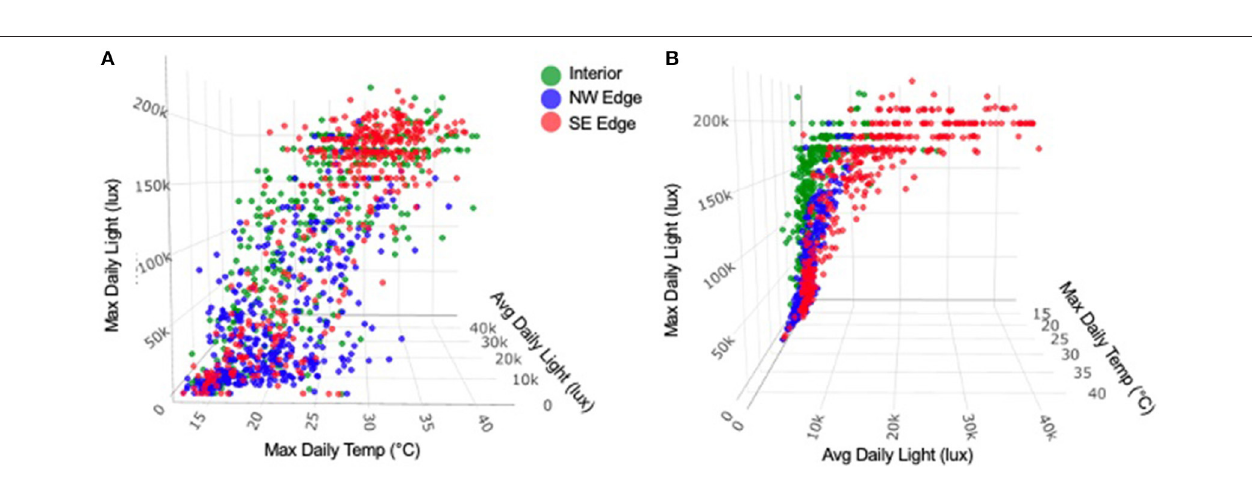
FIGURE 7 | Relationship between MaDL, ADL, and MaDT. The two interior locations were pooled with the aggregation location, since these three were not significantly different ( p > 0.6762) collectively or pairwise. (A) Grove interior had relatively low ADL in comparison to the SE (brightest) edge of the grove ( p < 0.0001). In addition, the inside of the grove has relatively high MaDL in comparison to the NW edge of the grove ( p < 0.0001), such that the interior of the grove is characterized by low ADL and high MaDL. This is possible if the maximum light is of short duration. (B) shows the positive correlation between MaDL and